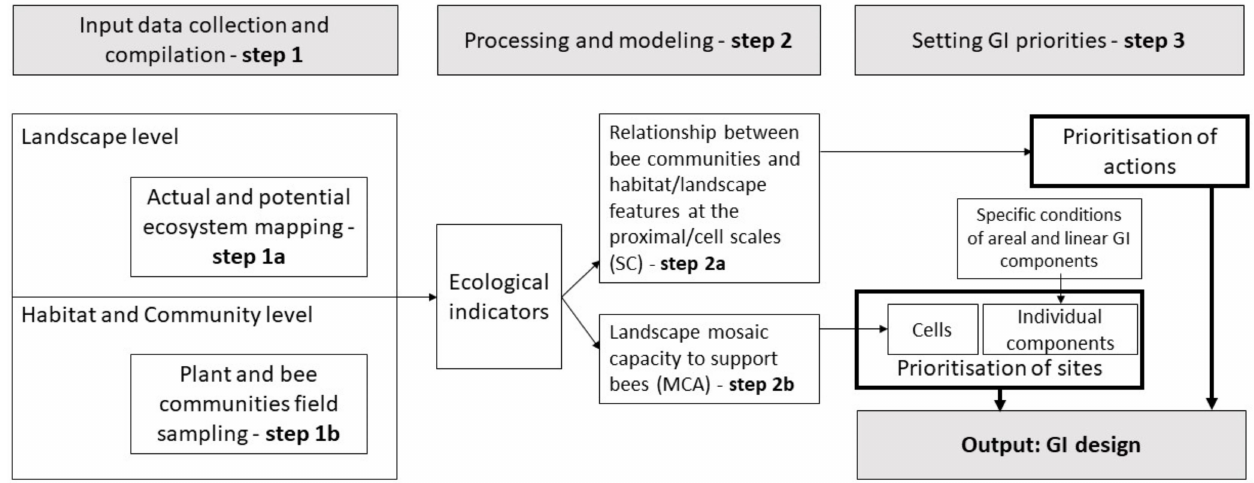
Figure 2. Multi-step procedure aimed at identifying and prioritising Green Infrastructure (GI) actions and sites (cells and individual components of the landscape mosaic) for pollinator support in the study